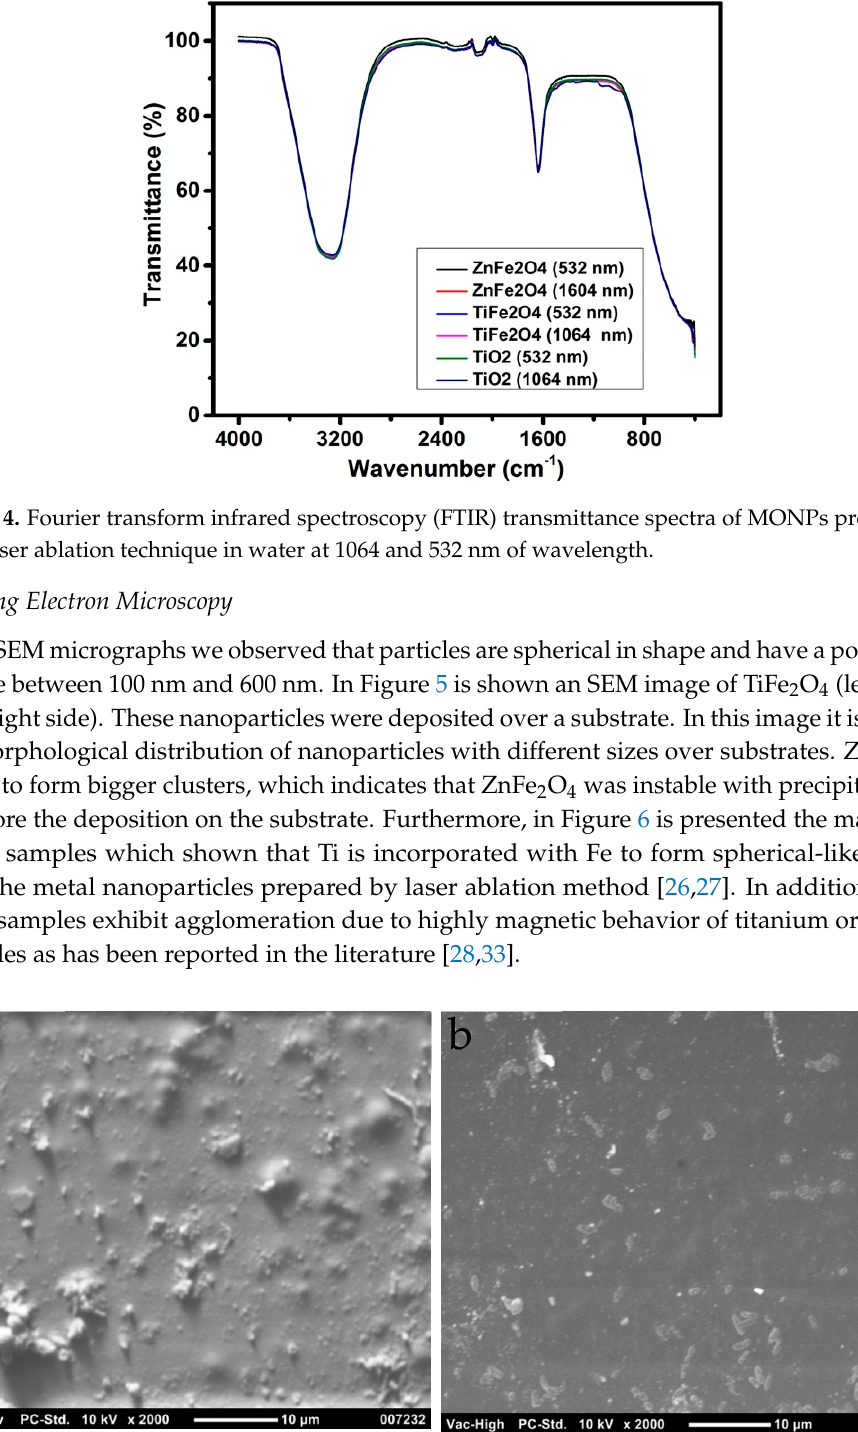
Figure 5. Scanning electron microscopy (SEM) images of ( a ) TiFe 2 O 4 and ( b ) ZnFe 2 O 4 nanoparticles dried over silica substrate.